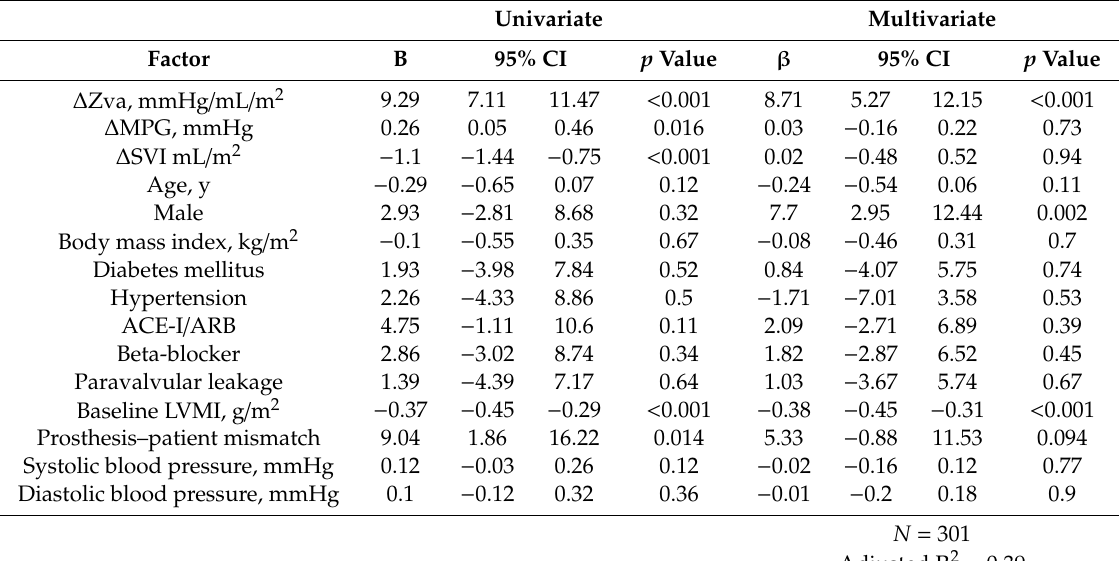
Table 4. Univariate and multivariate linear regression analyses to identify factors associated with ∆ LVMI. Univariate Multivariate Factor B 95% CI p Value ∆ Zva, mmHg / mL / m 2